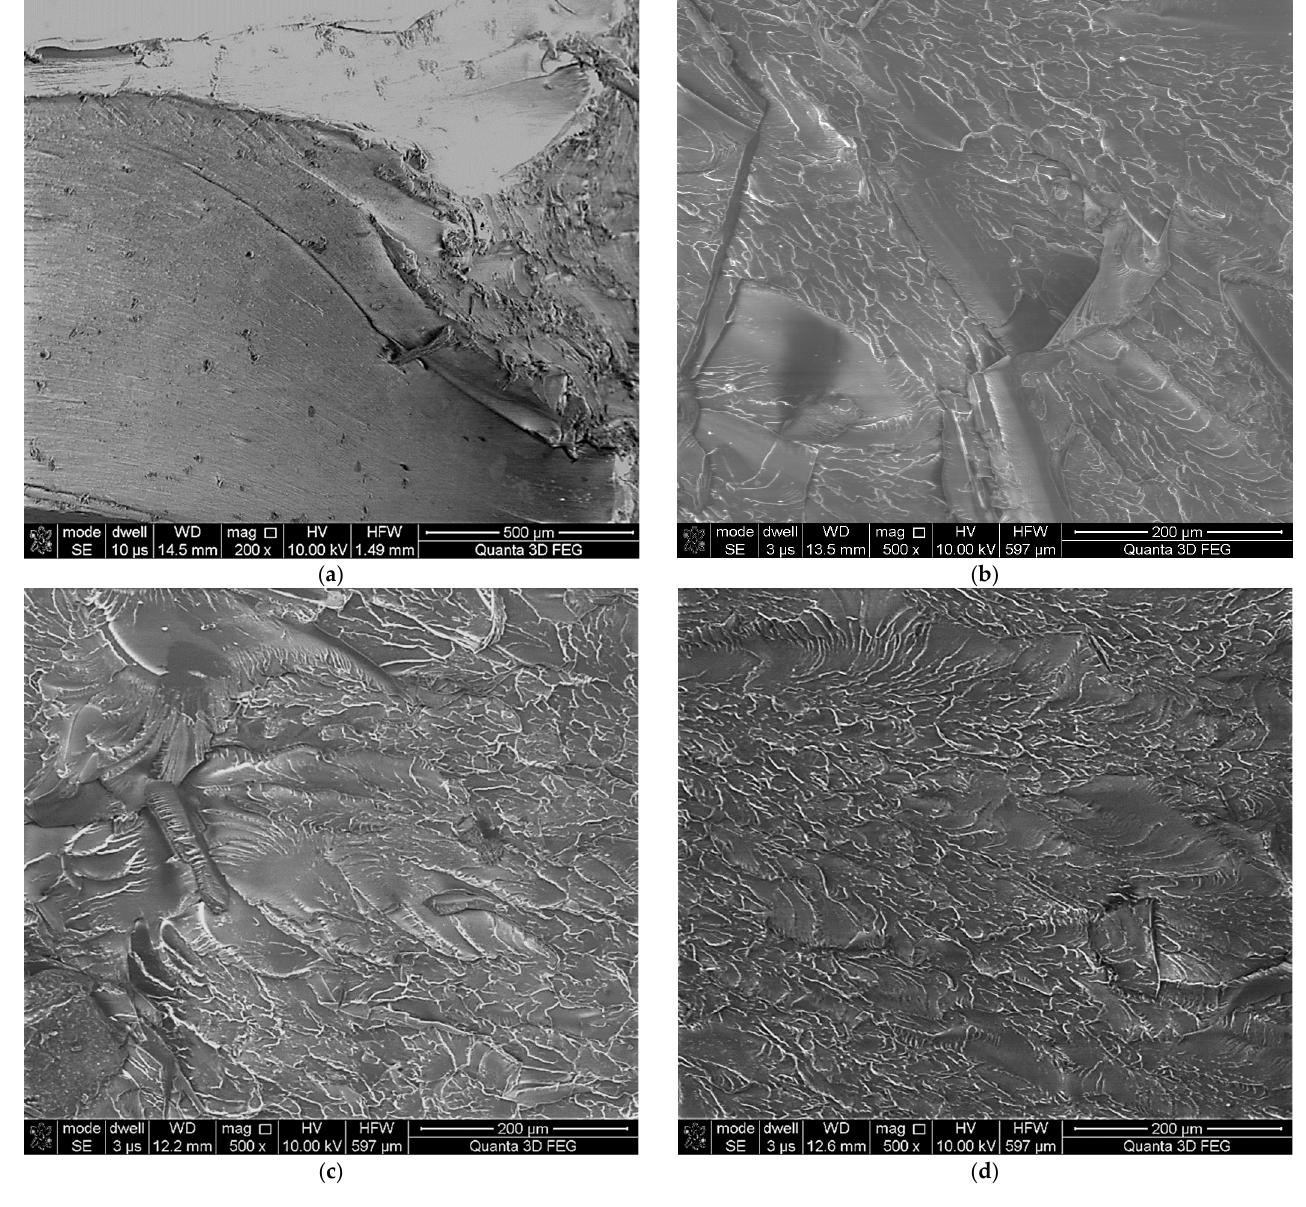
Figure 8. SEM micrographs of specimen fracture surface of as-received PET and 56 days aged PET. The tension test was carried out at 75 °C. Aging time; ( a ) as-received; ( b ) 21 days; ( c ) 35 days; ( d ) 56 days.